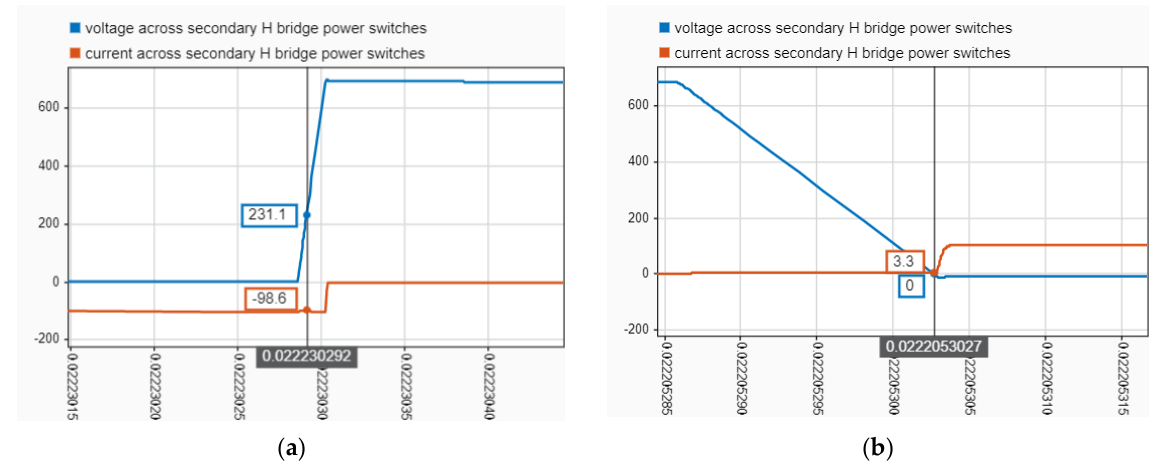
Figure 18. Current and voltage across a power switch of secondary H-bridge for 80 kW DAB DC-DC converter under optimal EPS operation, L = 3.15 µ H: ( a ) turn-off; ( b ) turn-on.